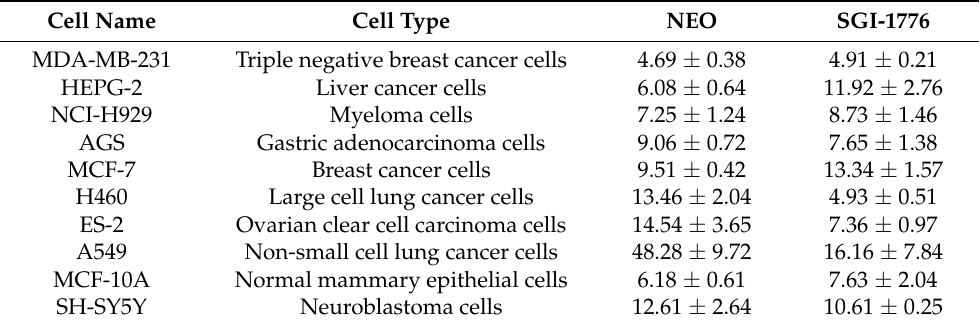
Table 1. Effects of NEO and SGI-1776 treatment on IC 50 ( µ M) of